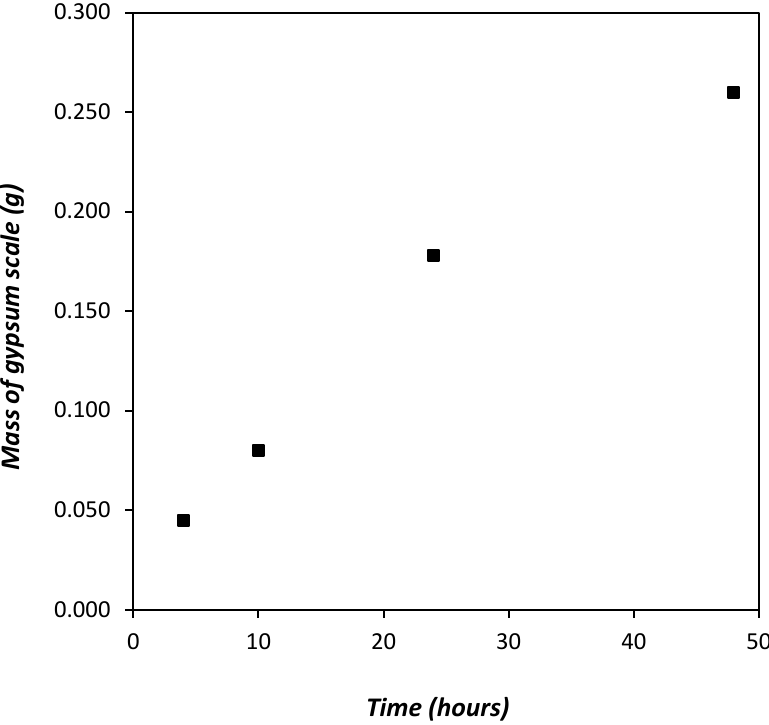
Figure 5. Mass of gypsum scale deposited on the stainless-steel tube as a function of time. Figure 6 shows the micrographs of the scaled tube after 48 h. In the micrographs, the darker phase represents the stainless-steel tube surface, and the lighter phase represents gypsum crystals.